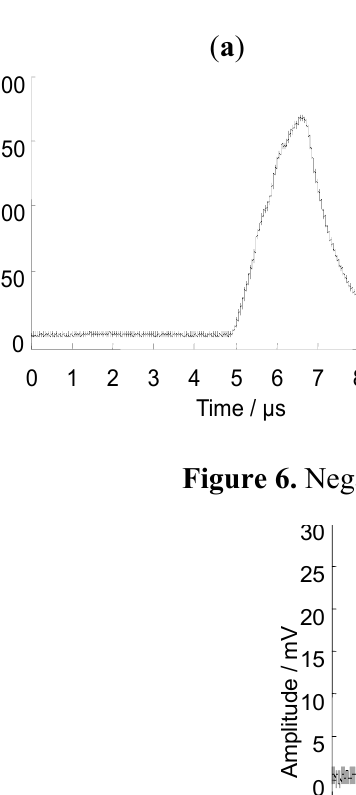
Figure 5. Positive PD optical pulses in transformer oil: ( a ) single-peak PD optical pulse; ( b ) multi-peak PD optical pulse.